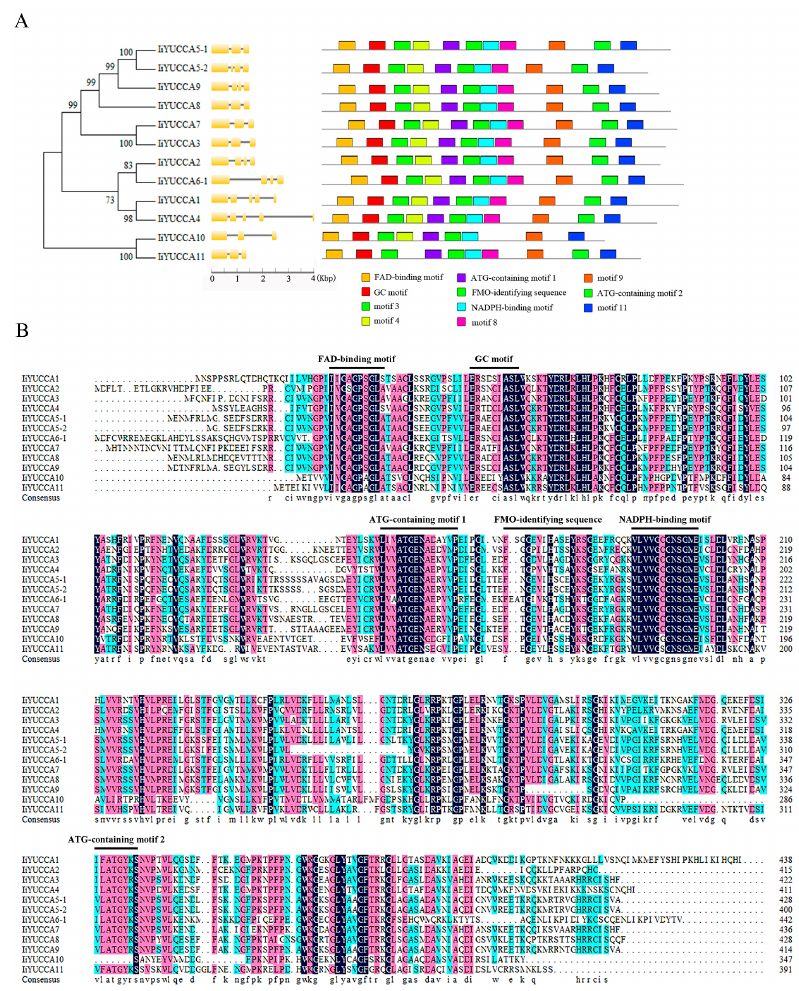
Figure 2. The phylogenetic tree, gene structure, multiple motifs ( A ), and multiple sequence alignment ( B ) of YUCCA gene family in I. indigotica . The gene structures of exons and introns are represented by yellow boxes and lines, respectively. The multiple conserved motifs were identified by MEME software, and they are labeled with colored boxes.